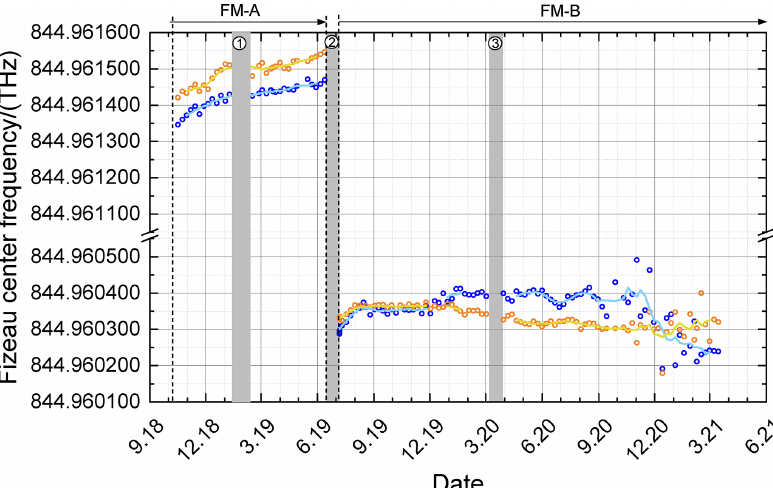
Figure 10. Fizeau center frequency derived from the direct channel (blue circles) and the reflected channel (orange circles) by fitting Eqs. (9) and (11) to the ISR data sets obtained from October 2018 to March 2021 (see also Table 2). The corresponding moving average of five successive data points is indicated by the light-blue line and yellow line, respectively. Special time periods are indicated by gray bars (1: instrument shut off due to a GPS reboot anomaly; 2: switch from FM-A to FM-B; 3: laser CPT